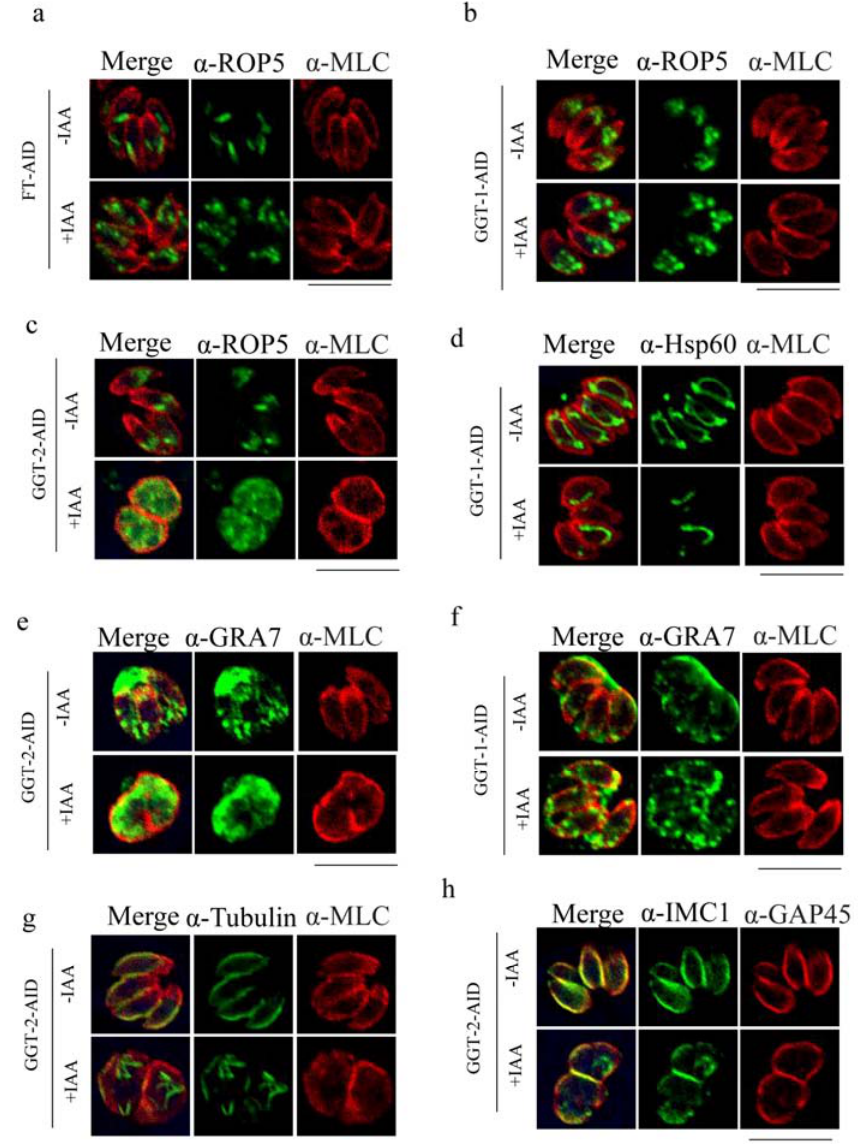
Figure 6. Degradation of FT, GGT-1 and GGT-2 affects the morphology of multiple organelles of parasites. ( a ) Effects of absence of FT on rhoptry. Effects of degradation of GGT-1 on rhoptry ( b ), mitochondrion ( d ) and GRA7 ( f ). Observation of morphology changes of rhoptry ( c ), GRA7 ( e ), microtubes ( g ) and inner membrane complex ( h ) after GGT-2 was degraded. IFA was performed to observe the morphology of organelles. MLC or GAP45 was used to label the outer plasma of parasite (red), target proteins were stained with green color, and the yellow color symbolized the merged localization between the target protein and the outer plasma of parasite in this assay. ROP5, Hsp60, Tubulin and IMC1 were symbolized as the markers of rhoptry, mitochondrion, microtubes and inner membrane complex, respectively. Scare bars: 10 µM.